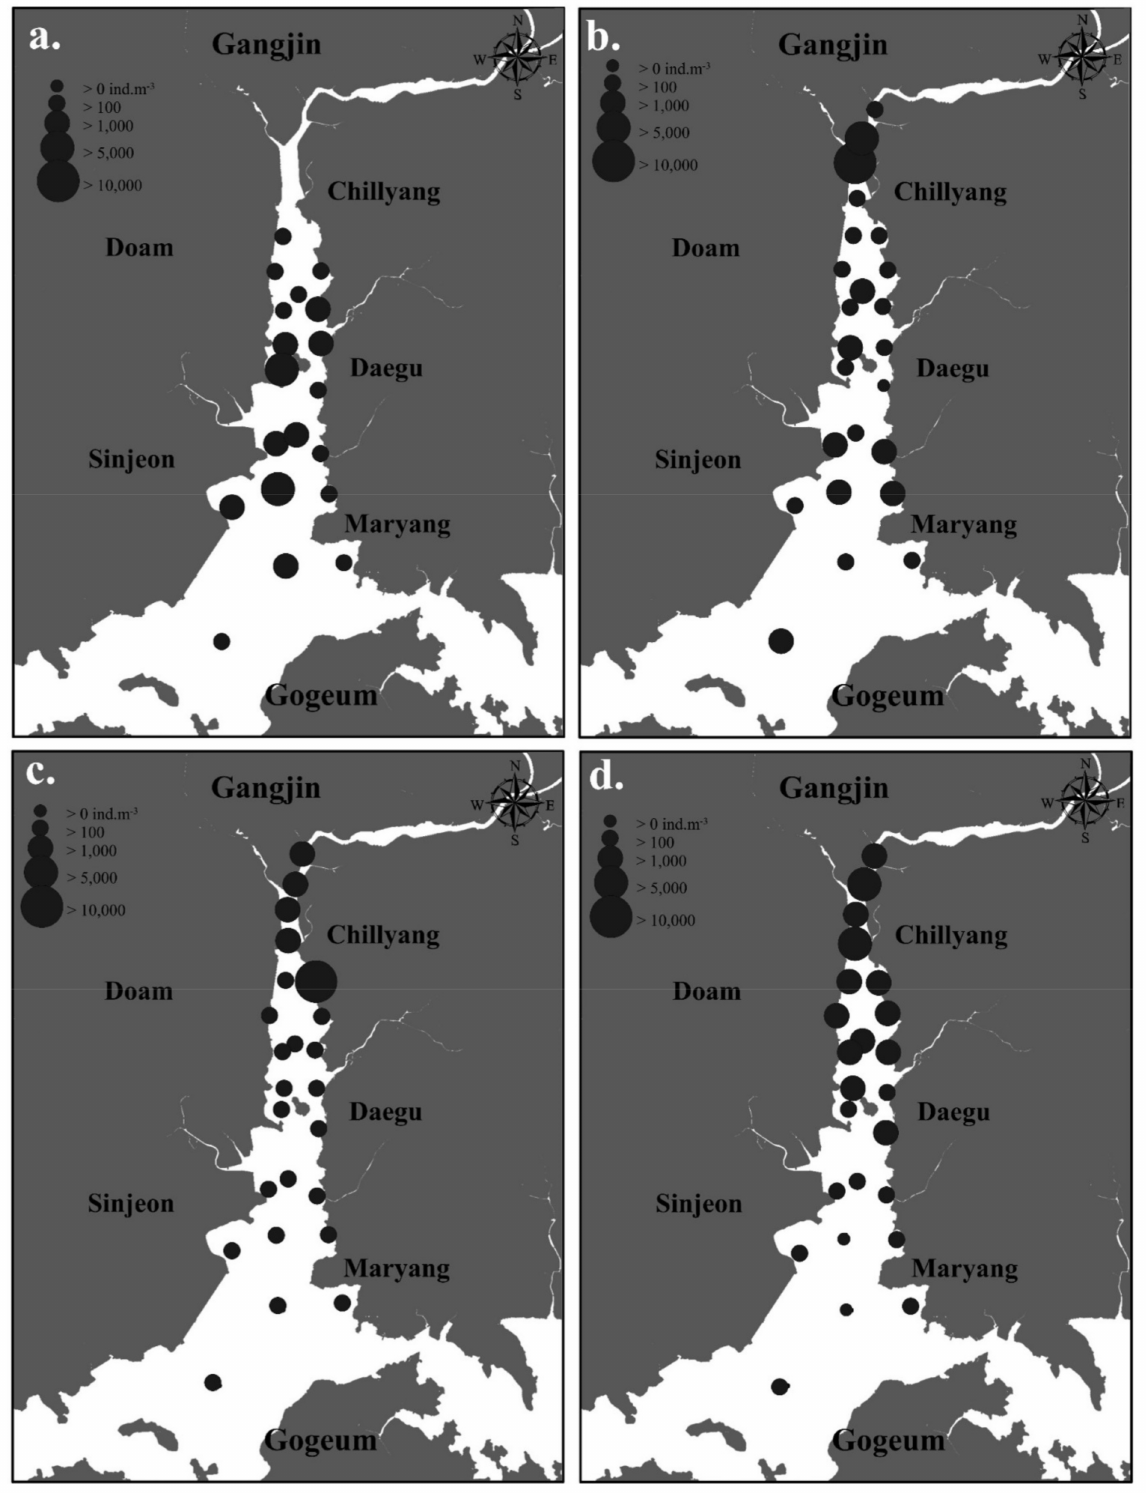
Figure 7. Horizontal distribution of copepod abundance (ind./m 3 ) during the study period: ( a ) spring, ( b ) summer, ( c ) fall, ( d )